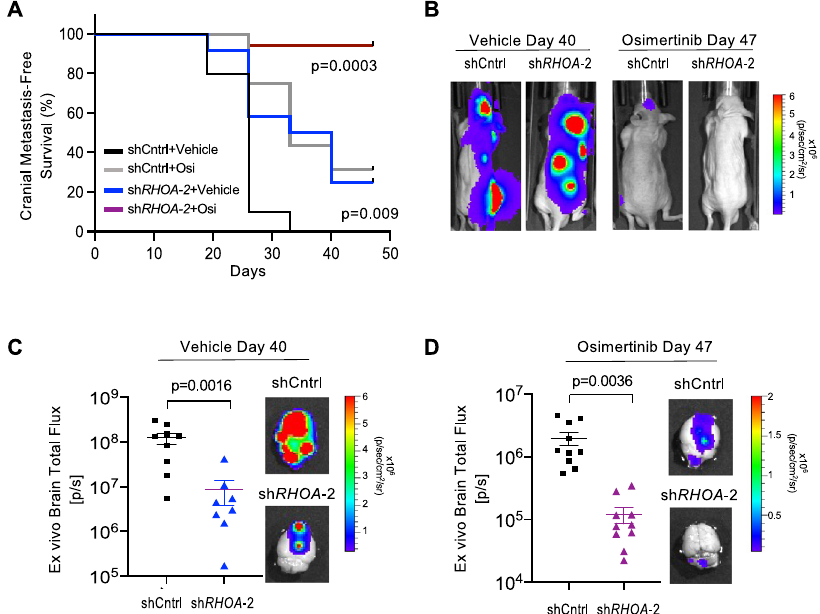
Fig.8|RhoAinhibitiondecreasesbrainmetastaticoutgrowthandosimertinib resistance in vivo. A Kaplan – Meier analysis of brain metastasis incidence follow- ing intracardiac injection of R2 shCntrl or R2 sh RHOA − 2 cells into mice that were maintained on a Dox food diet and treated with either vehicle or osimertinib starting 12 days after injection. Brain metastasis incidence was detected by BLI. N =10 animals for shCntrl/vehicle, N =16 animals for shCntrl/osimertinib, N =12 animals for sh RHOA-2/ vehicle, and N =17 animals for sh RHOA-2 /osimertinib. P - values of shRHOA groups (compared to shCntrl+Vehicle) calculated by log-rank test. B Representative BLI images of animals with median cranial tumor burden